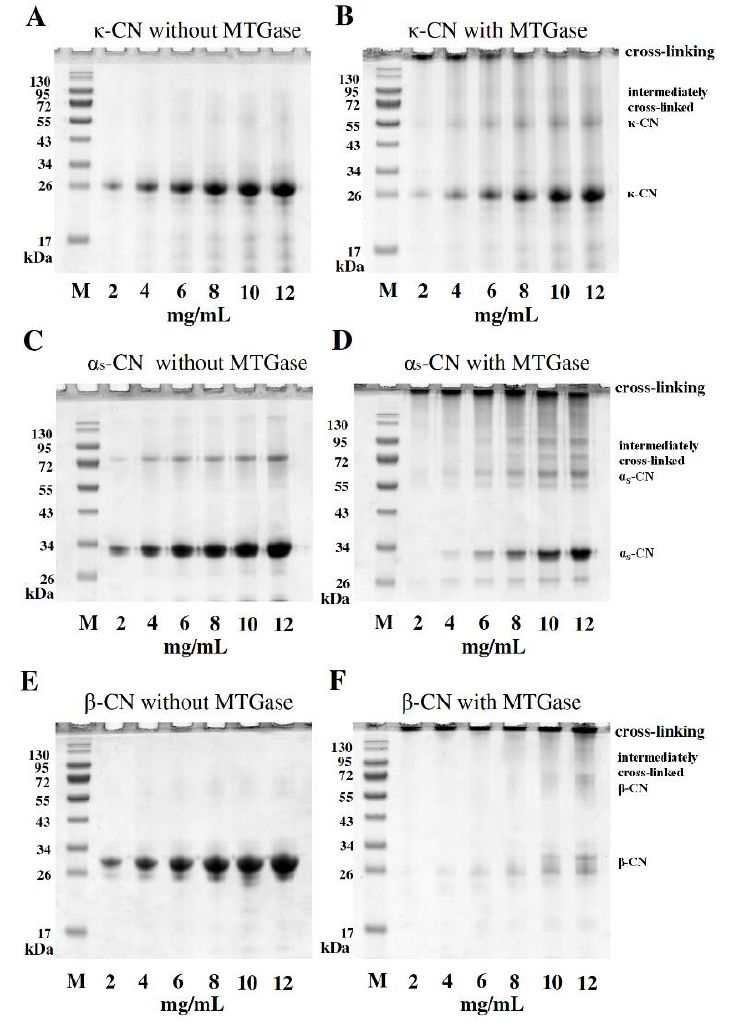
Figure 2. SDS-PAGE profiles from the cross-linking reaction of varying amounts of casein proteins (2-12 mg/mL) without/with 2.0 units/mL MTGase at 30 °C for 1 h. SDS-PAGE gels were loaded using 5 μL individual caseins with protein concentrations of 10, 20, 30, 40, 50, and 60 μg/well, respectively. ( A ) κ -CN without MTGase; ( B ) κ -CN with MTGase; ( C ) α S -CN without MTGase; ( D ) α S -CN with MTGase; ( E ) β -CN without MTGase; and ( F ) β -CN with MTGase; M: protein marker.